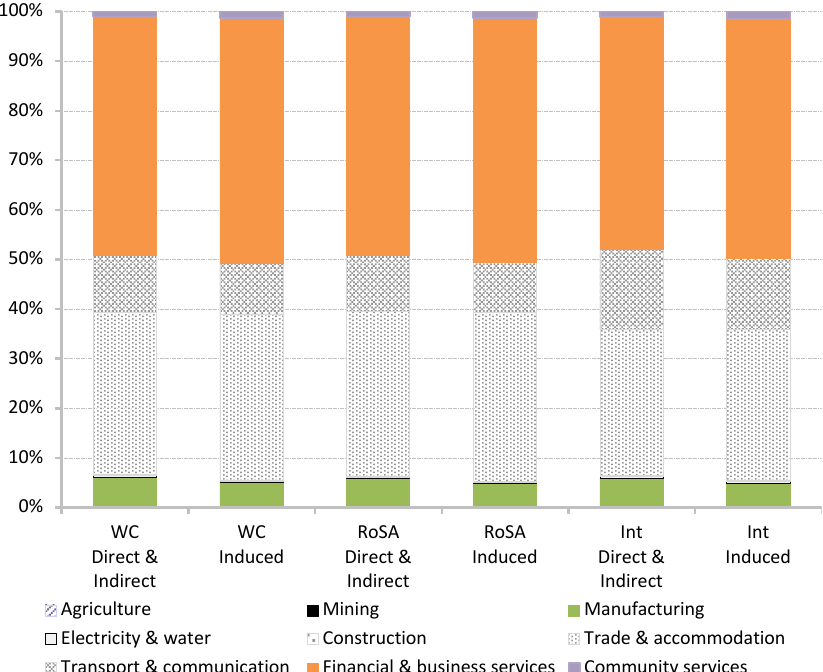
FIGURE 2: Visitors’ expenditure in the region per activity sector Source: Authors’ analysis Total impact of the TMNP on production (in ZAR millions, 2006 prices) Sector